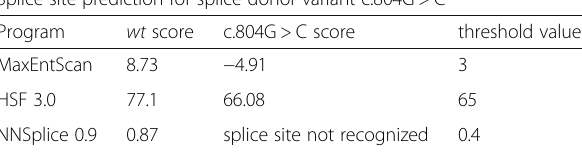
Table 3 Results from in-silico analysis of the splice donor site of the intron 10. Scores for wild-type and c.804G > C sequences are presented Splice site prediction for splice donor variant c.804G >